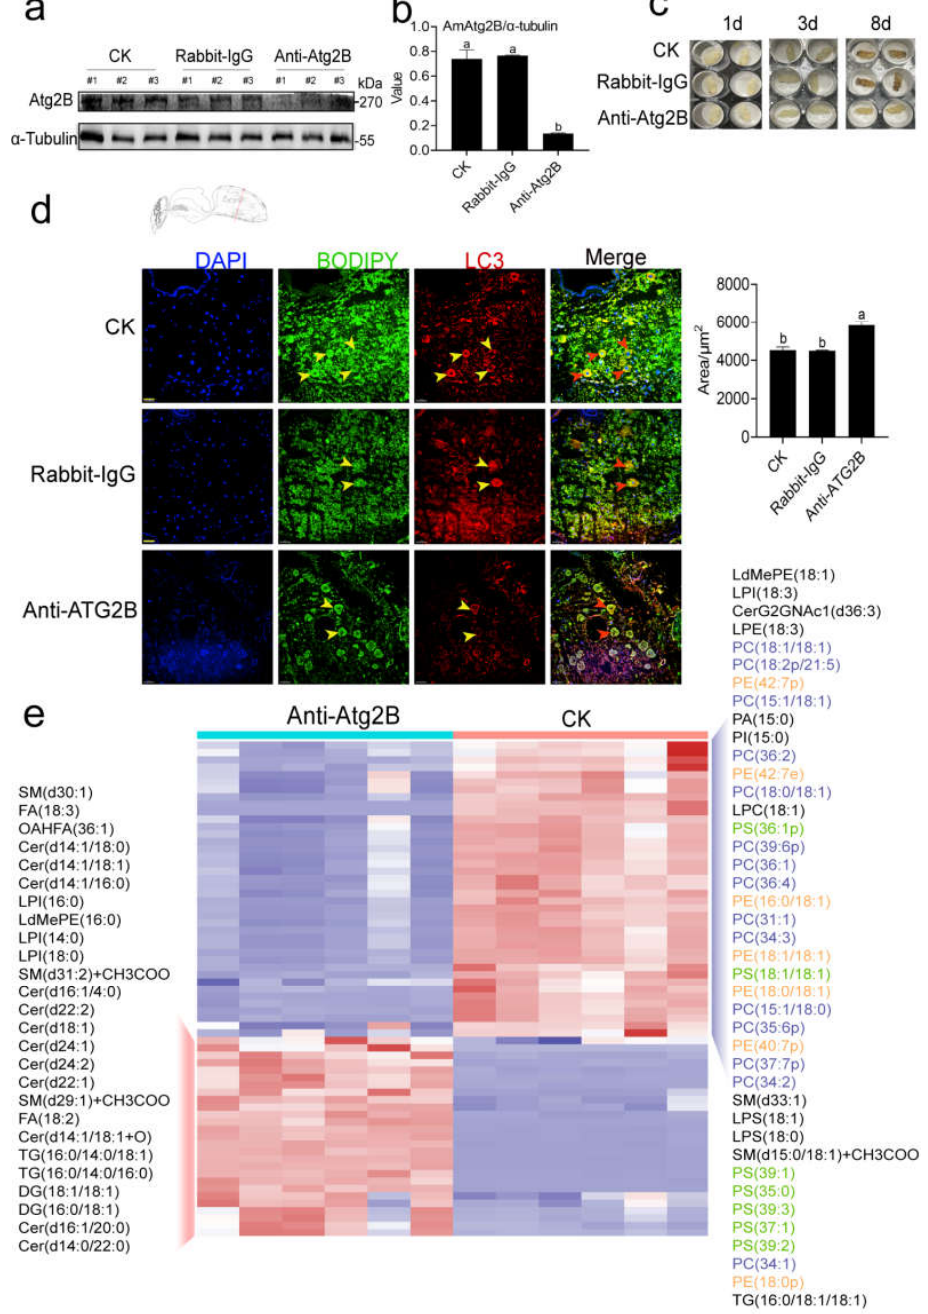
Figure 4. Neutralization of AmAtg2B repressed lipophagy of fat body and lipid metabolism in Apis mellifera pupae. ( a ) Western blot image showed that AmAtg2B levels of pupae decreased with the injection of Anti−Atg2B antibodies, compared with group Rabbit−IgG and CK. Rabbit−IgG was a negative control for the antibody and statistical analysis of normalized quantification of mean gray intensity by the ImageJ software ( n = 3) ( b ). ( c ) Phenotype of pupae after injection of Anti−Atg2B antibodies for 1 d, 3 d, and 8 d (4 μg was injected into Pw); ( d ) Co−localization of BODIPY 493/503 (green) with LC3 (red) in group CK, IgG and (Anti−Atg2B). Statistical analysis of the fat body area (green) by the ImageJ software ( n = 6). Scale bar: 100 μm. ( e ) Heatmap showing the differential lipid metabolites between group CK and Anti−Atg2B. Note: Data are shown as mean ± SEM and the different letters marked on the bar chart represent significant differences ( p < 0.05).